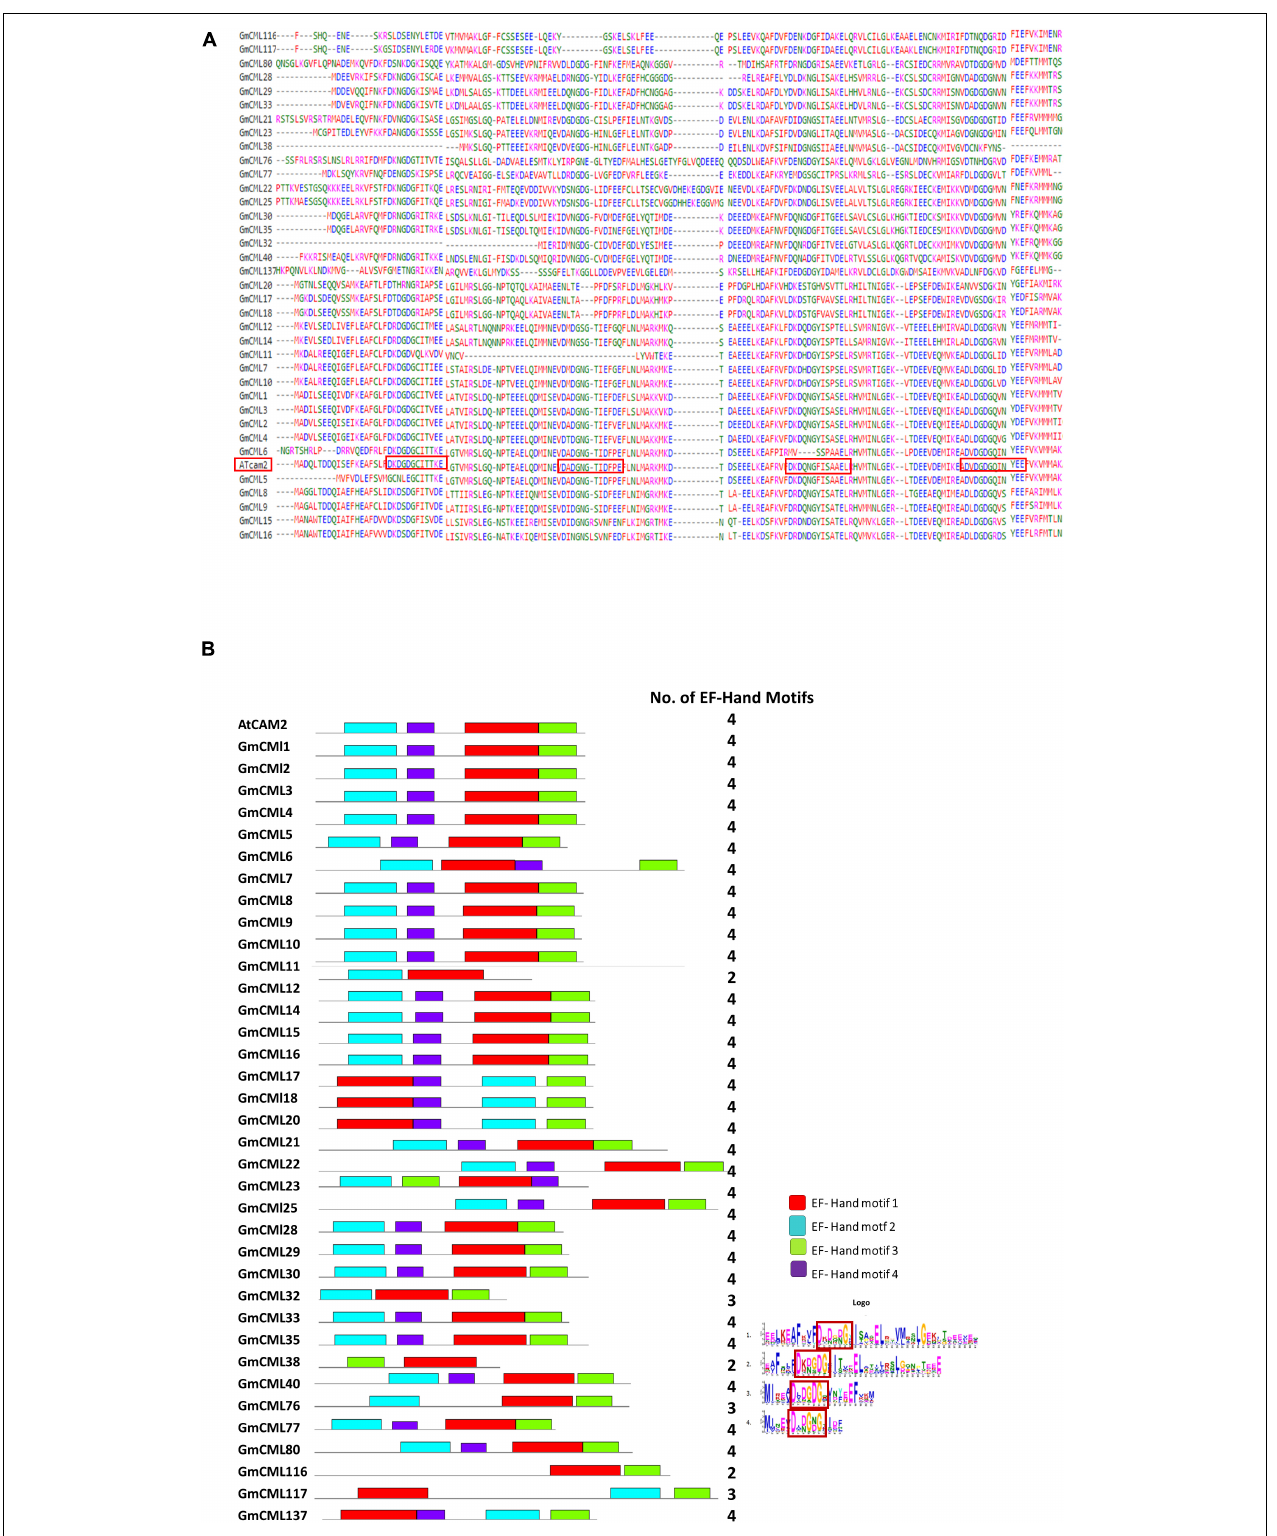
FIGURE 5 | Identification of EF-hands in GmCMLs by in silico method. The presence of EF-hands (number varied from 2 to 4) in GmCMLs are presented (A) . The boxes represent the EF-hands present in each GmCMLs. The logoplot shows the presence of respective number of EF-hands in GmCMLs (generated by MEME suite) (B) . The colored boxes indicate the number of EF-hand motifs at the corresponding position within GmCMLs. Different colors indicate different EF-hand motifs.